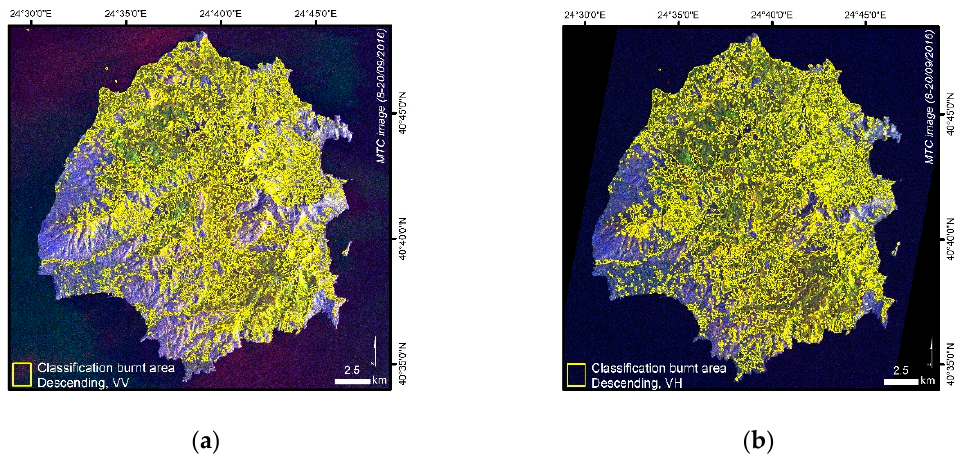
Figure 6. Results of the classification of the ( a ) descending mode and VV polarization and ( b ) descending mode and VH polarization.